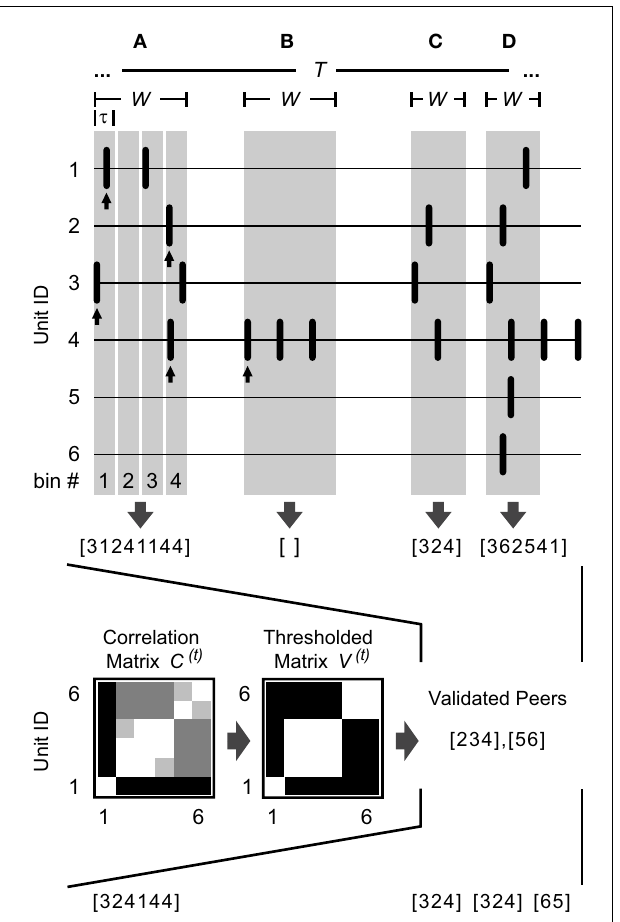
FIGURE 1 | Detection of spatiotemporal firing patterns. Illustrated are six simultaneously recorded spike trains and four separately detected patterns (A–D) as examples. An arbitrary time window W (highlighted in gray) is used in each case to define the spatiotemporal activity pattern.The units that coincide in the given time window are further split into subgroups according to previously validated peers: Based on the number of coincident events of any two units during some period t of length T (raw correlation matrix C ( t ) ) and a threshold, units are classified as being functionally coupled or uncoupled (thresholded correlation matrix V ( t ) , see text for details). In this example, units 2, 3, and 4 are correlated, as are units 5 and 6, and unit 1 is not correlated with any other unit. (A) A 60ms window containing six spikes falling into different 15ms bins given by τ .The resulting pattern is represented by a vector indicating the constituent units ranked by appearance ([3124...]), followed by the corresponding bin numbers of their first spikes ([...1144], see arrows). After comparison with the sets of validated peers, unit 1 is excluded from the pattern. (B) Since a pattern consists of at least two spikes and only the first spike of each unit inside the window is considered (see arrow), patterns comprising only one unit are skipped ( W = 60ms). (C,D) If no binning is applied, the vector representing the pattern indicates only the temporal order of the participating units ( W = 35ms). (C) After comparison with the sets of validated peers, the pattern is left unmodified. (D) After comparison with the sets of validated peers, the pattern is split into two subpatterns and unit 1 is